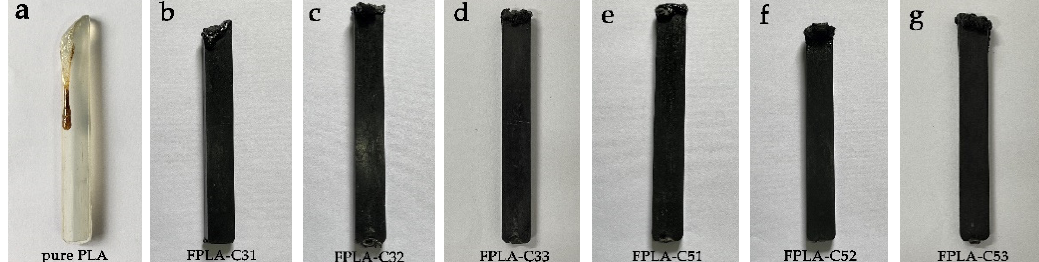
Figure 10. Digital images of PLA and FPLA composites after LOI tests: ( a ) pure PLA; ( b ) 3CS/10BC-m/87PLA; ( c ) 3CS/20BC-m/77PLA; ( d ) 3CS/30BC-m/67PLA; ( e ) 5CS/10BC-m/85PLA; ( f ) 5CS/20BC-m/75PLA; ( g ) 5CS/30BC-m/65PLA.